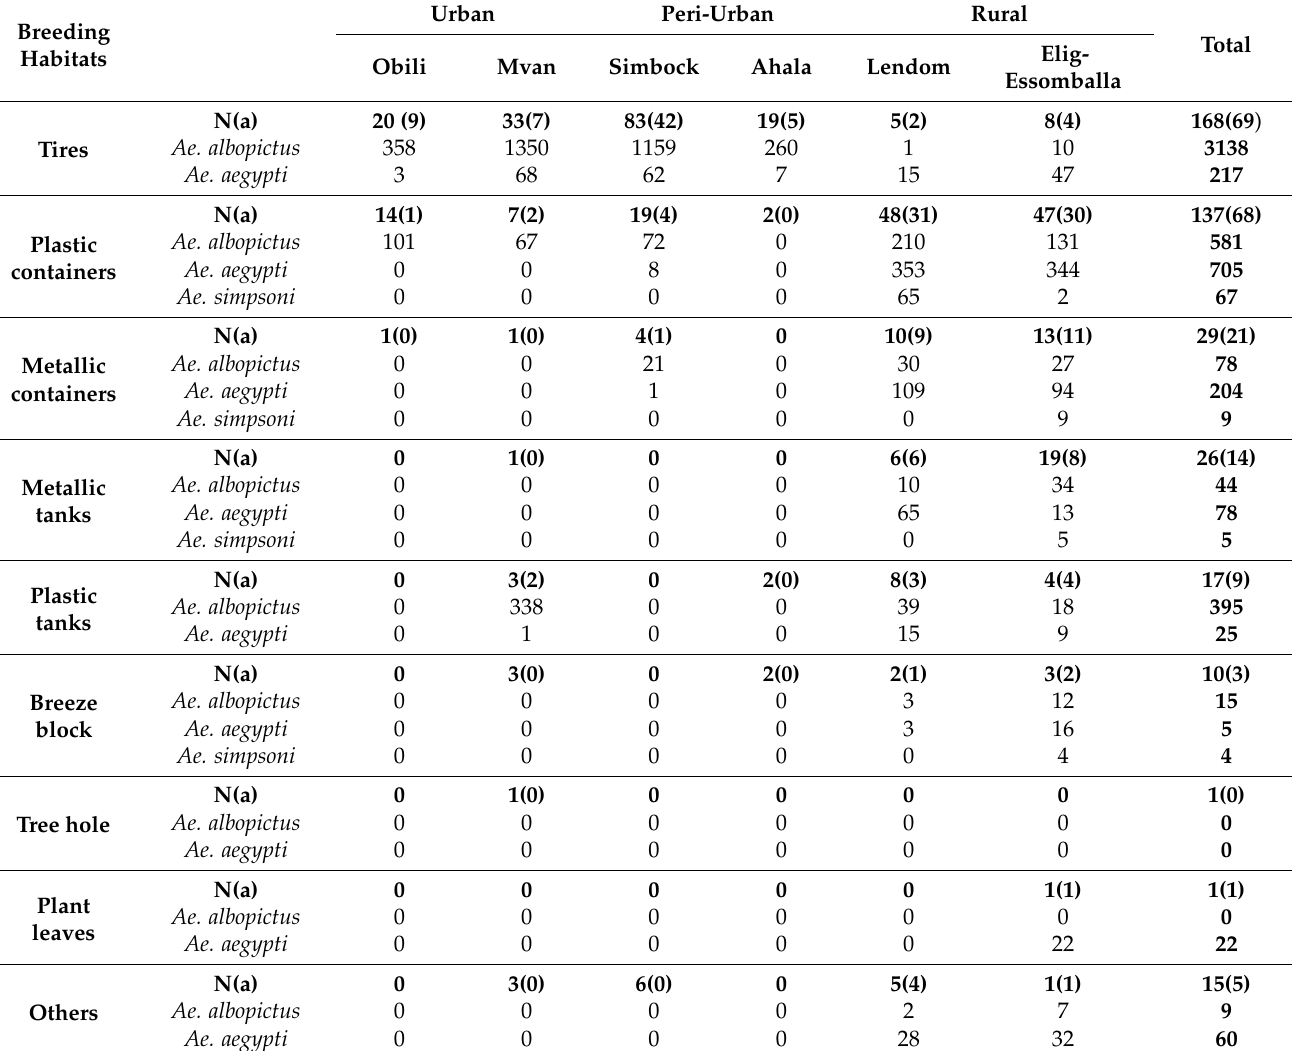
Table 3. Type of breeding habitats recorded with Aedes mosquito larvae in urban, peri-urban and rural settings. Breeding